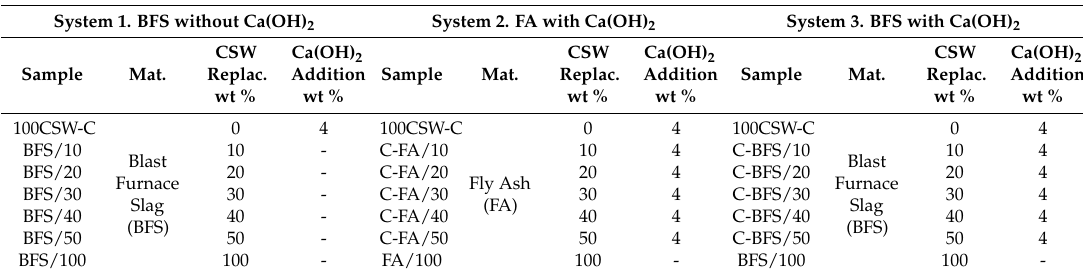
Table 1. Designation of samples, ceramic sanitaryware (CSW) replacement with blast furnace slag (BFS), or fly ash (FA), and samples with Ca(OH) 2 addition.